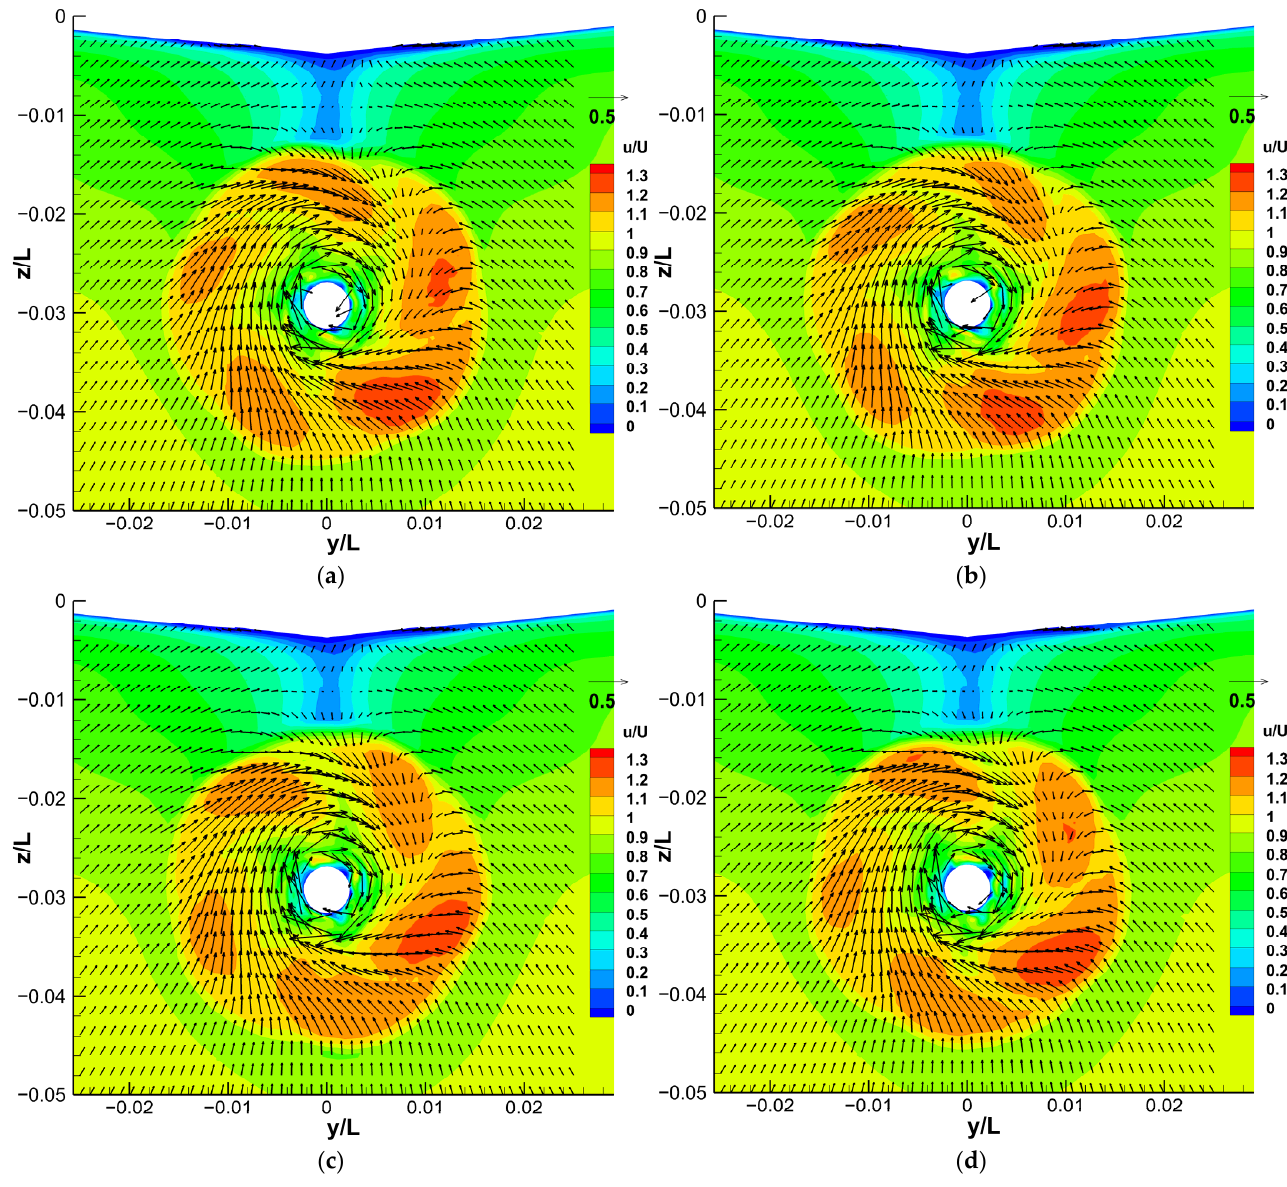
Figure 20. Flow field after propeller ( x/L = 0.985) for the rotating blade model when the index blade is near: ( a ) 0-degree position; ( b ) 18-degrees position; ( c ) 36-degrees position; ( d ) 54-degrees posi- tion.